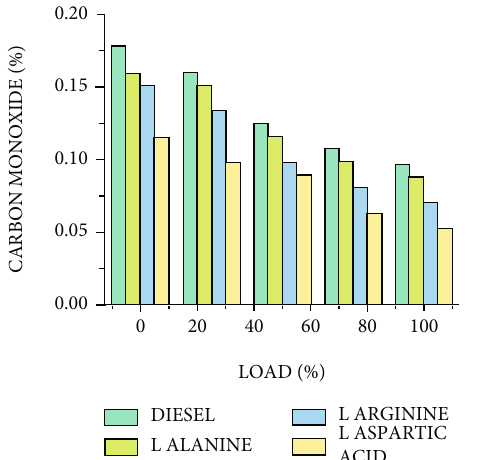
Figure 15: Variation of O load.